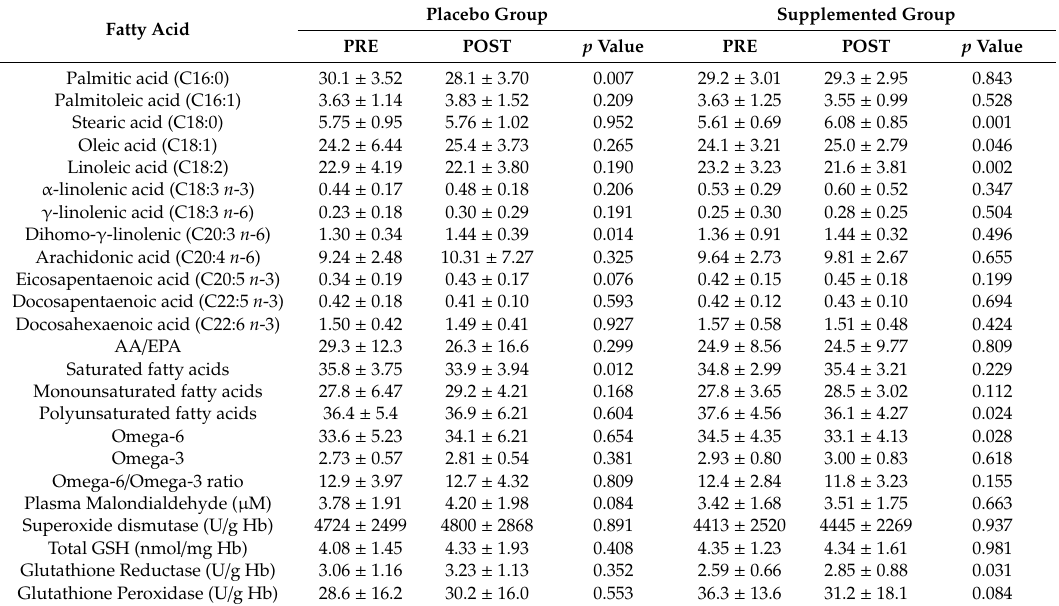
Table 3. Effects of a 30-day clinical trial on plasma fatty acids and oxidative stress markers of physical activity and amino acid supplementation in elderly sarcopenic subjects ( n = 69 in the supplementation group, n = 61 in the placebo